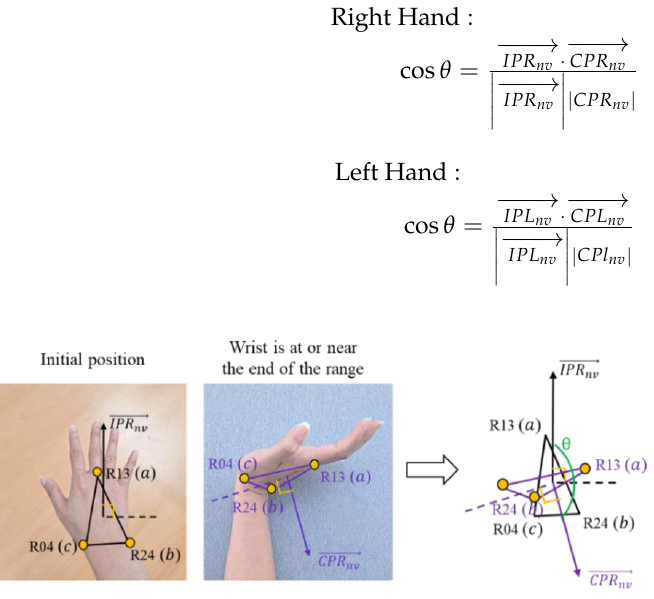
Figure 9. Wrist twist position in the range.